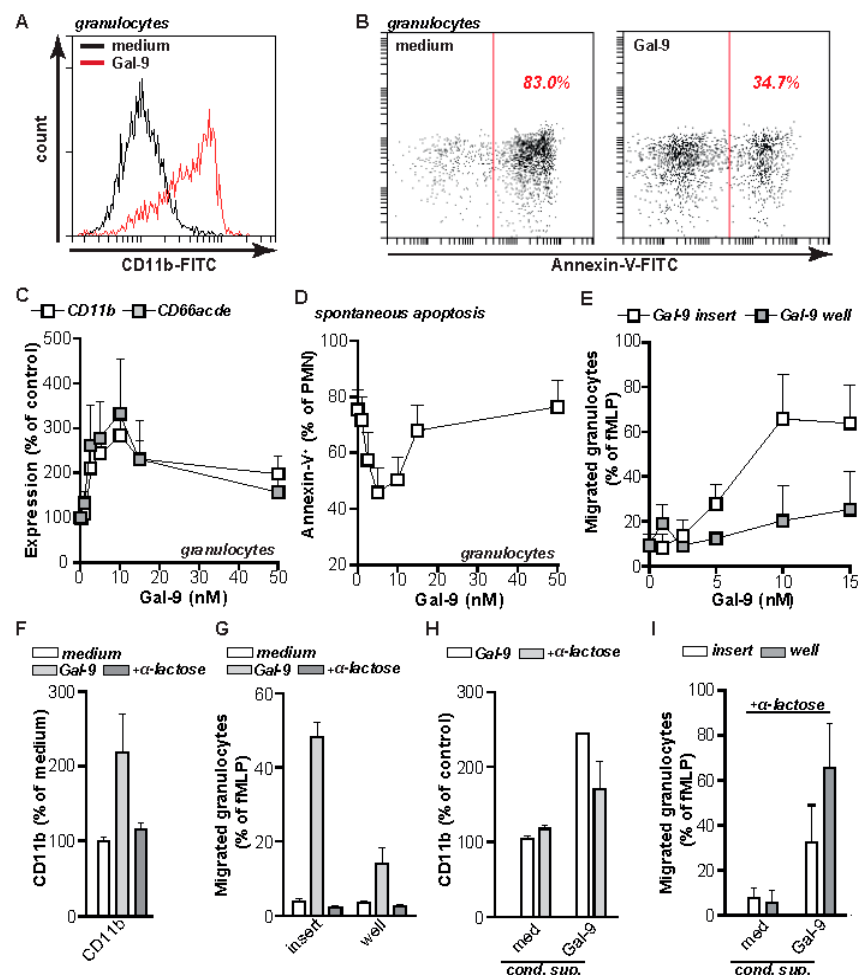
Figure 3. Gal-9 activates inflammatory functions in granulocytes. ( A ) Expression of CD11b on granulocytes after 16 h treatment with 15 nM Gal-9, determined by flow cytometry. ( B ) Granulocytes were treated with 15 nM Gal-9 for 16 h and analyzed for spontaneous apoptosis by measuring PS-exposure using Annexin-V-FITC. ( C ) Expression of CD11b and CD66acde on granulocytes after 16 h treatment with increasing concentrations of Gal-9, determined by flow cytometry. ( D ) Granulocytes were treated with increasing concentrations of Gal-9 for 16 h and analyzed for spontaneous apoptosis by measuring PS-exposure using Annexin-V-FITC. ( E ) Granulocyte cell migration after 16 h of incubation with Gal-9 using a trans-well system. ( F ) Gal-9-induced CD11b expression the presence of α -lactose. ( G ) Gal-9-induced granulocyte migration in the presence of α -lactose (40 mM). ( H ) As in ( A ), using Gal-9 or conditioned supernatant of Gal-9 treated leukocytes +/ − α -lactose (40 mM) to inhibit direct Gal-9-mediated e ff ects. ( I ) As in ( E ), using Gal-9 or conditioned supernatant of Gal-9 treated leukocytes in the presence of α -lactose (40 mM) to inhibit direct Gal-9-mediated e ff ects. All experiments were at least performed in triplicate with granulocytes from independent donors.